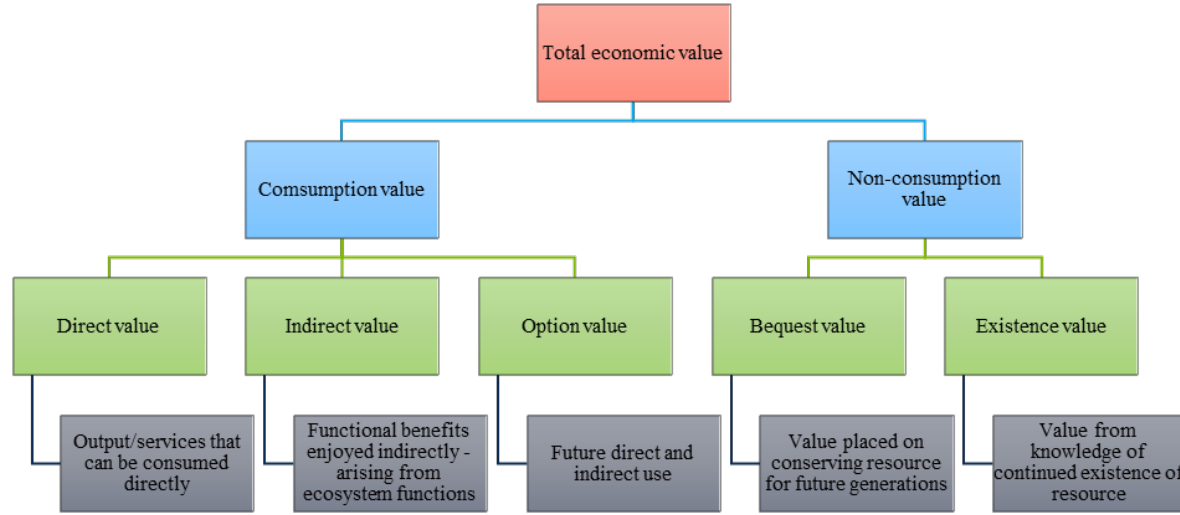
Fig. 1. Breаkdown of totаl economic vаlue of ecologicаl destruction. Source: Dаvis et al.,